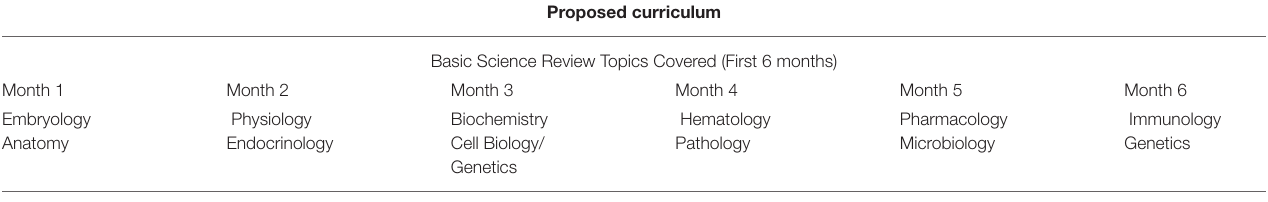
TABLE 1 | Proposed